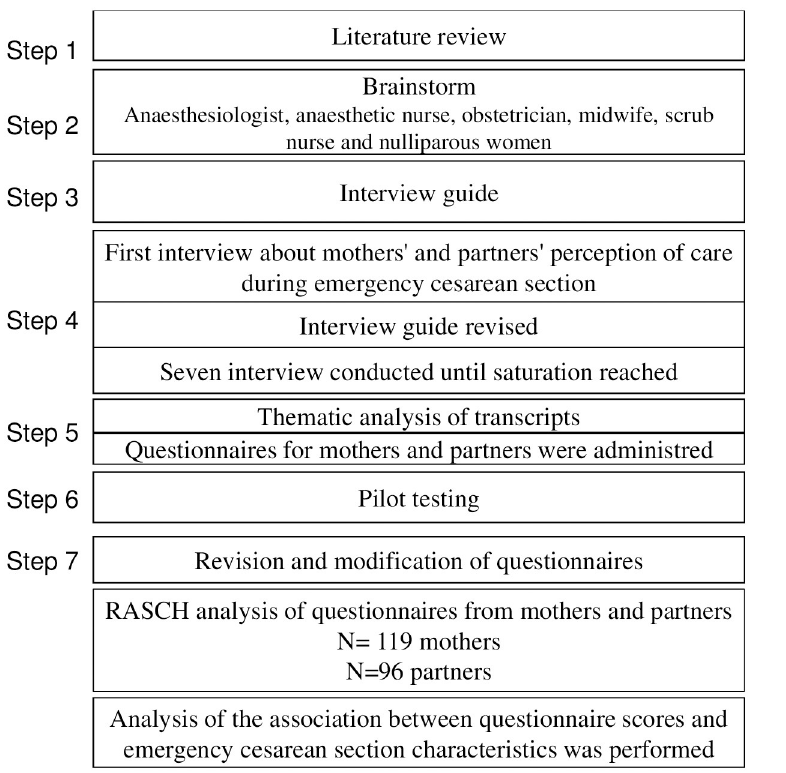
Fig 1. Study process and questionnaire